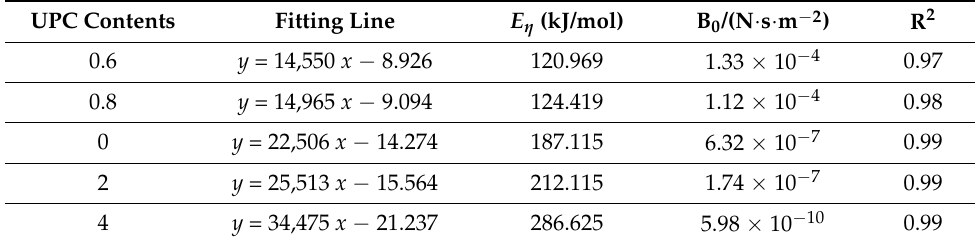
Table 3. Dynamics parameters of the viscous flow activation